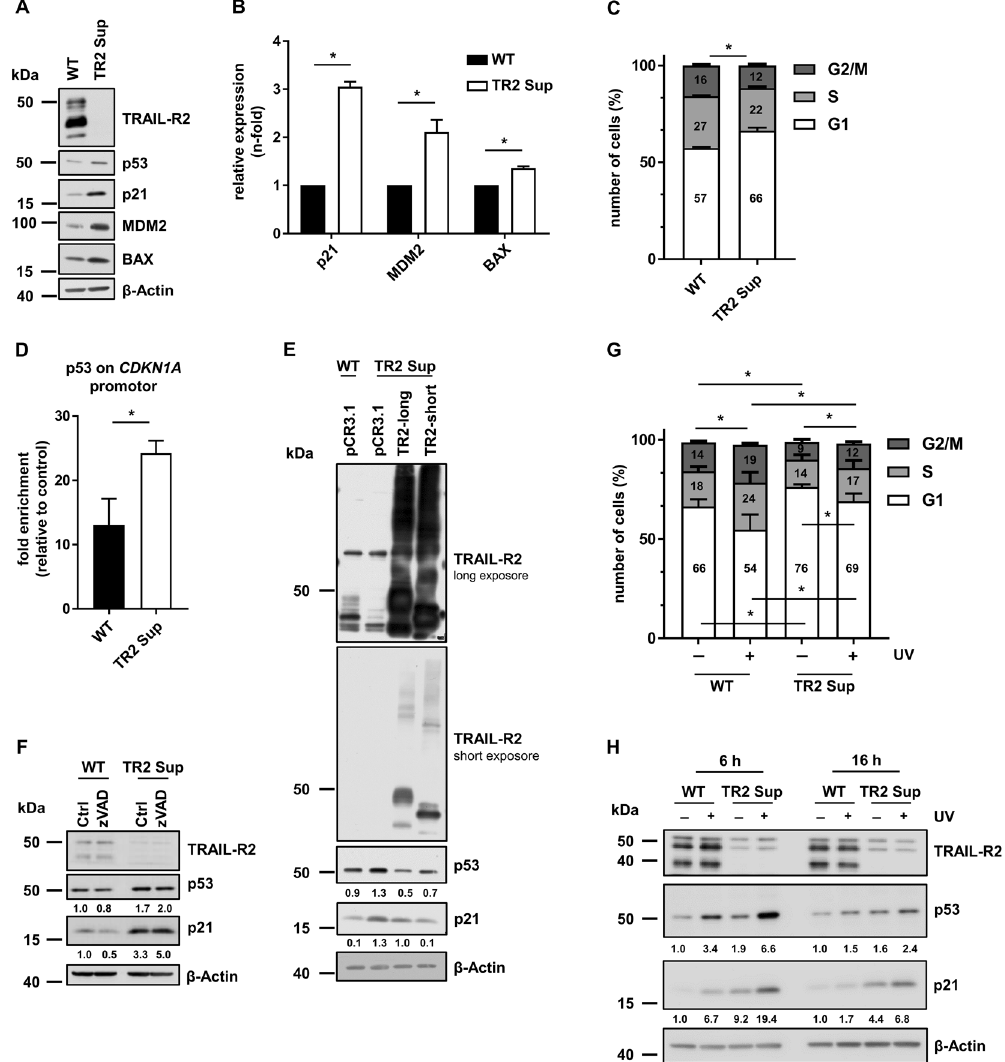
Fig. 3 TRAIL-R2 modulates p53 transcriptional activity independently of caspases. A Whole-cell lysates of A549 wild type (WT) and TRAIL- R2-Sup (TR2 Sup) cells were analyzed by western blotting for the protein levels of TRAIL-R2, p53, MDM2, BAX, and p21. The level of β -Actin was determined in parallel and served as loading control. B mRNA levels of p21, MDM2 and BAX were analyzed by qRT-PCR in A549 cells and normalized to TBP. Bar chart shows mean values ± SD of three biological replicates ( n = 3). C Cell cycle analysis through PI staining followed by fl ow cytometry of A549 WT and TRAIL-R2-Sup cells. Bar chart shows mean values ± SD of three biological replicates ( n = 3). D Chromatin Immunoprecipitation (ChIP) was performed with anti-p53 (DO-1) and isotype control antibodies (IgG 2a ) on chromatin isolated from A549 WT and TRAIL-R2 Sup cells. DNA was extracted, and qRT-PCRs were performed using primers detecting the CDKN1A promotor. Enrichment was calculated as the fold increase in speci fi c signal relative to the background signal. Results are shown ± SEM of four biological replicates ( n = 4). E A549 WT and TRAIL-R2 Sup cells were transiently transfected with expression vector coding for the long (TR2-long) or short (TR2-short) isoform of TRAIL-R2, each carrying a point mutation in the death domain, or with an empty vector (pCR3.1). After 48 h, protein levels of TRAIL-R2, p53, and p21 were analyzed by western blotting. The level of β -Actin was determined in parallel and served as loading control. Bands were analyzed by densitometry. Intensity of each band was normalized to the corresponding β -Actin. F A549 cells were treated with zVAD-fmk (20 µM) for 48 h. Whole-cell lysates were analyzed by western blotting for the expression of TRAIL-R2, p53, and p21. The level of β -Actin was determined in parallel and served as loading control. G A549 WT and TRAIL-R2 Sup cells were irradiated with 10 J/m 2 of UV-C radiation. After 16 h cell cycle analysis through PI staining followed by fl ow cytometry was performed. Bar chart shows mean values ± SD of three biological replicates ( n = 3). H A549 WT and TRAIL-R2 Sup cells were irradiated with 10 J/m 2 of UV-C radiation. After 6 h and 16 h whole-cell lysates were prepared and analyzed by western blotting for the expression of TRAIL-R2, p53, and p21. β -Actin was analyzed in parallel as loading control. * p <